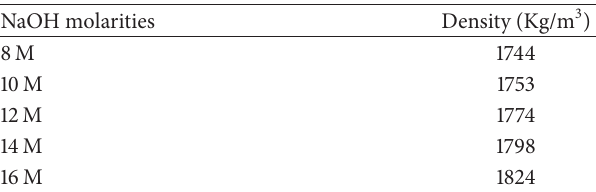
Table 7: The density of OPSGPC in different molarities of alkali